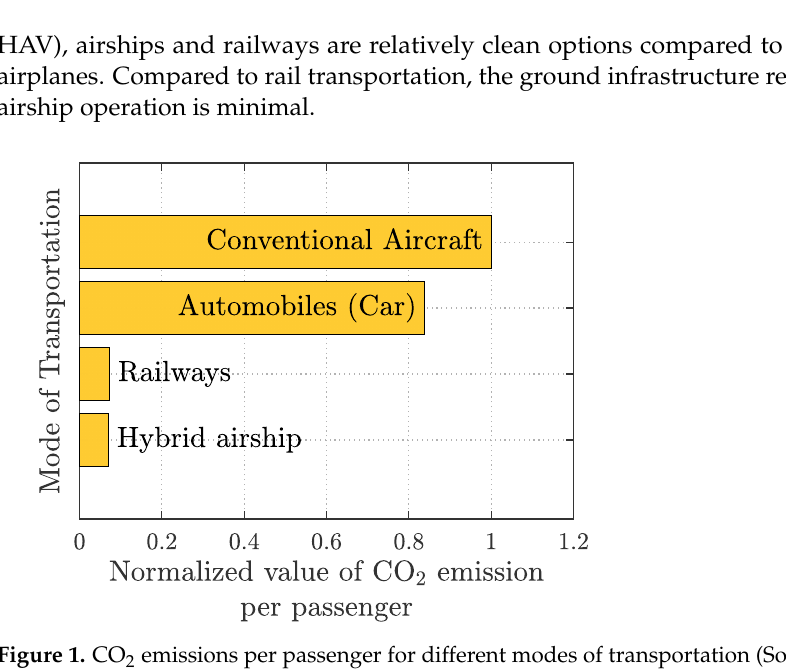
Figure 1. CO 2 emissions per passenger for different modes of transportation (Source of data: